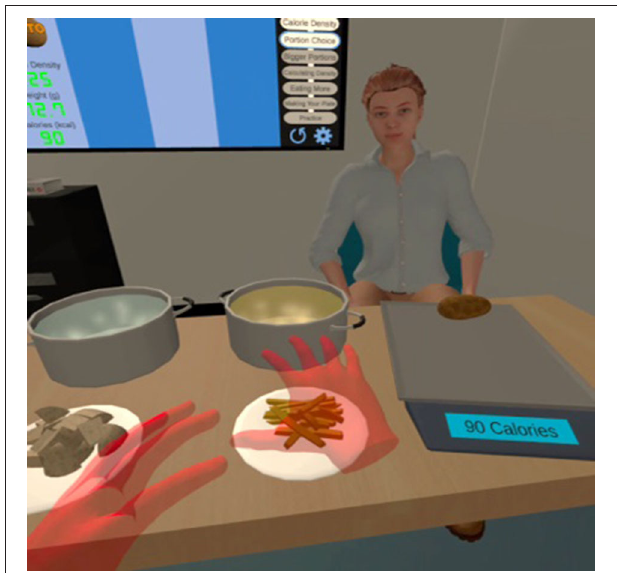
the option to indicate their dominant hand and adjust the height of their virtual self in proportion to the virtual environment to the degree they feel comfortable. FIGURE 2 | Preparing food: boiled (left) vs. deep fried (right)